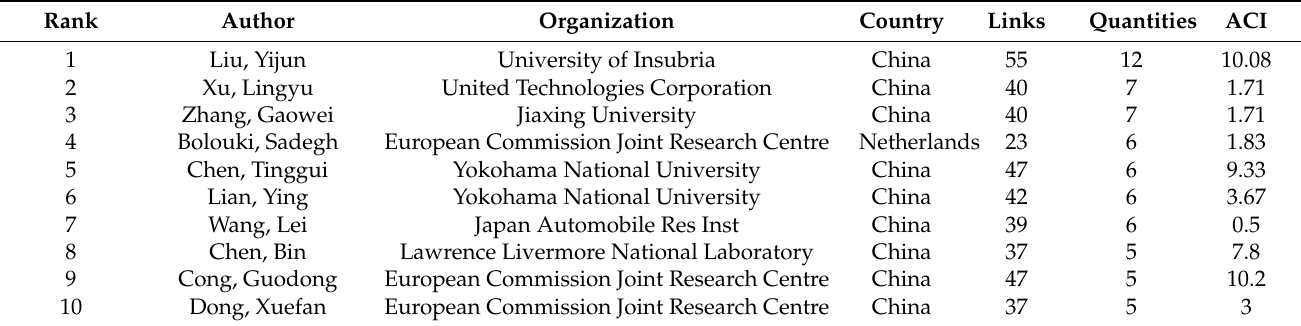
Table 6. Top 10 authors in NPO studies,